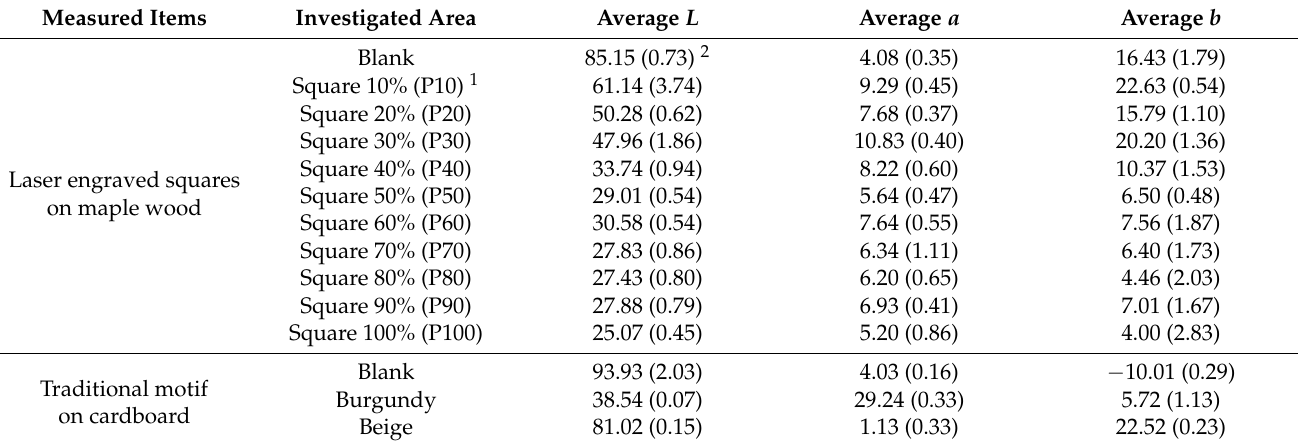
Table 1. Color analysis. Average experimentally recorded data L , a , b and standard